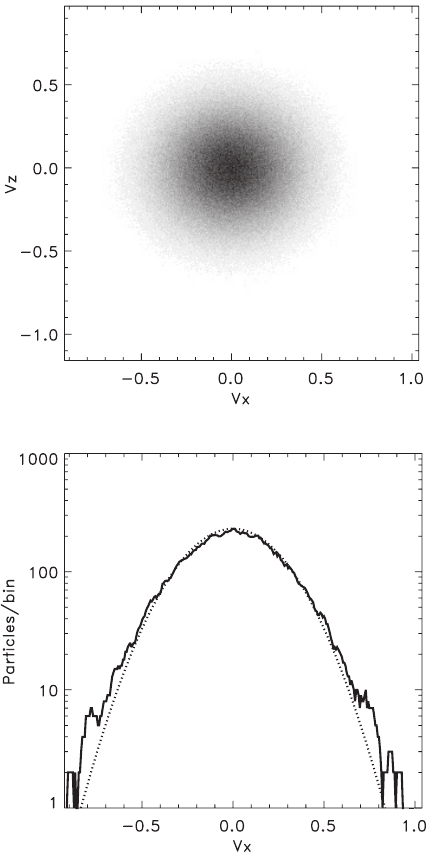
Fig. 3. The perpendicular velocity distribution of He ++ ions (top) and the corresponding cut of the distribution at V z = 0 showing best fit Maxwellian distribution (dashes). The velocity is in units of the Alfv´en speed.